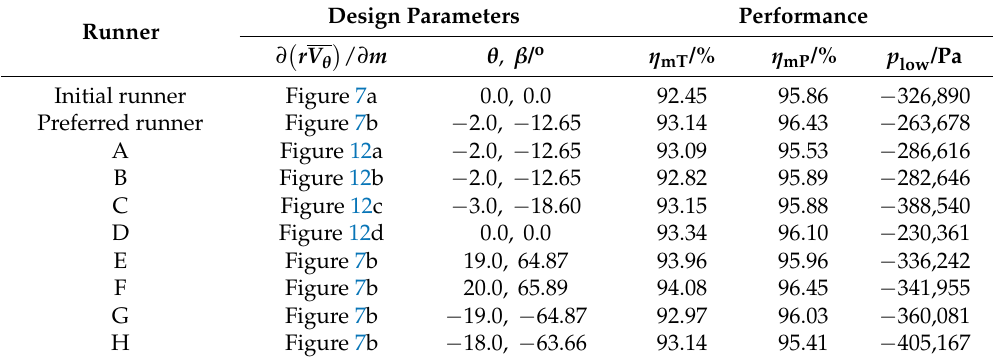
Table 6. Design parameters and performances of the runners.